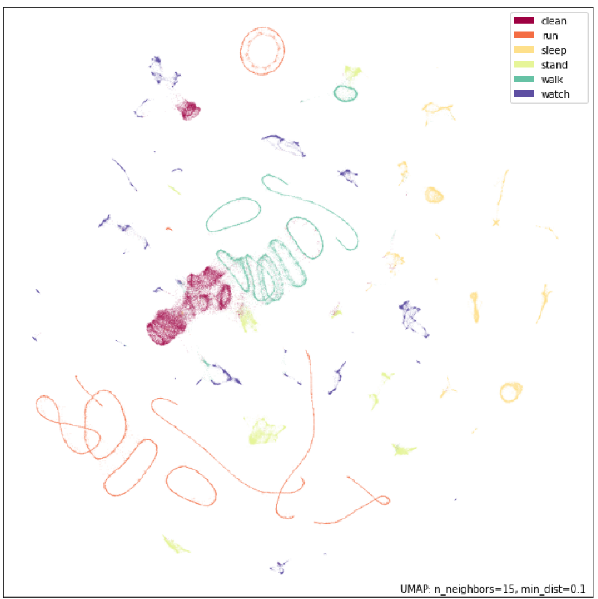
Figure 3. Visualization description of the dataset.